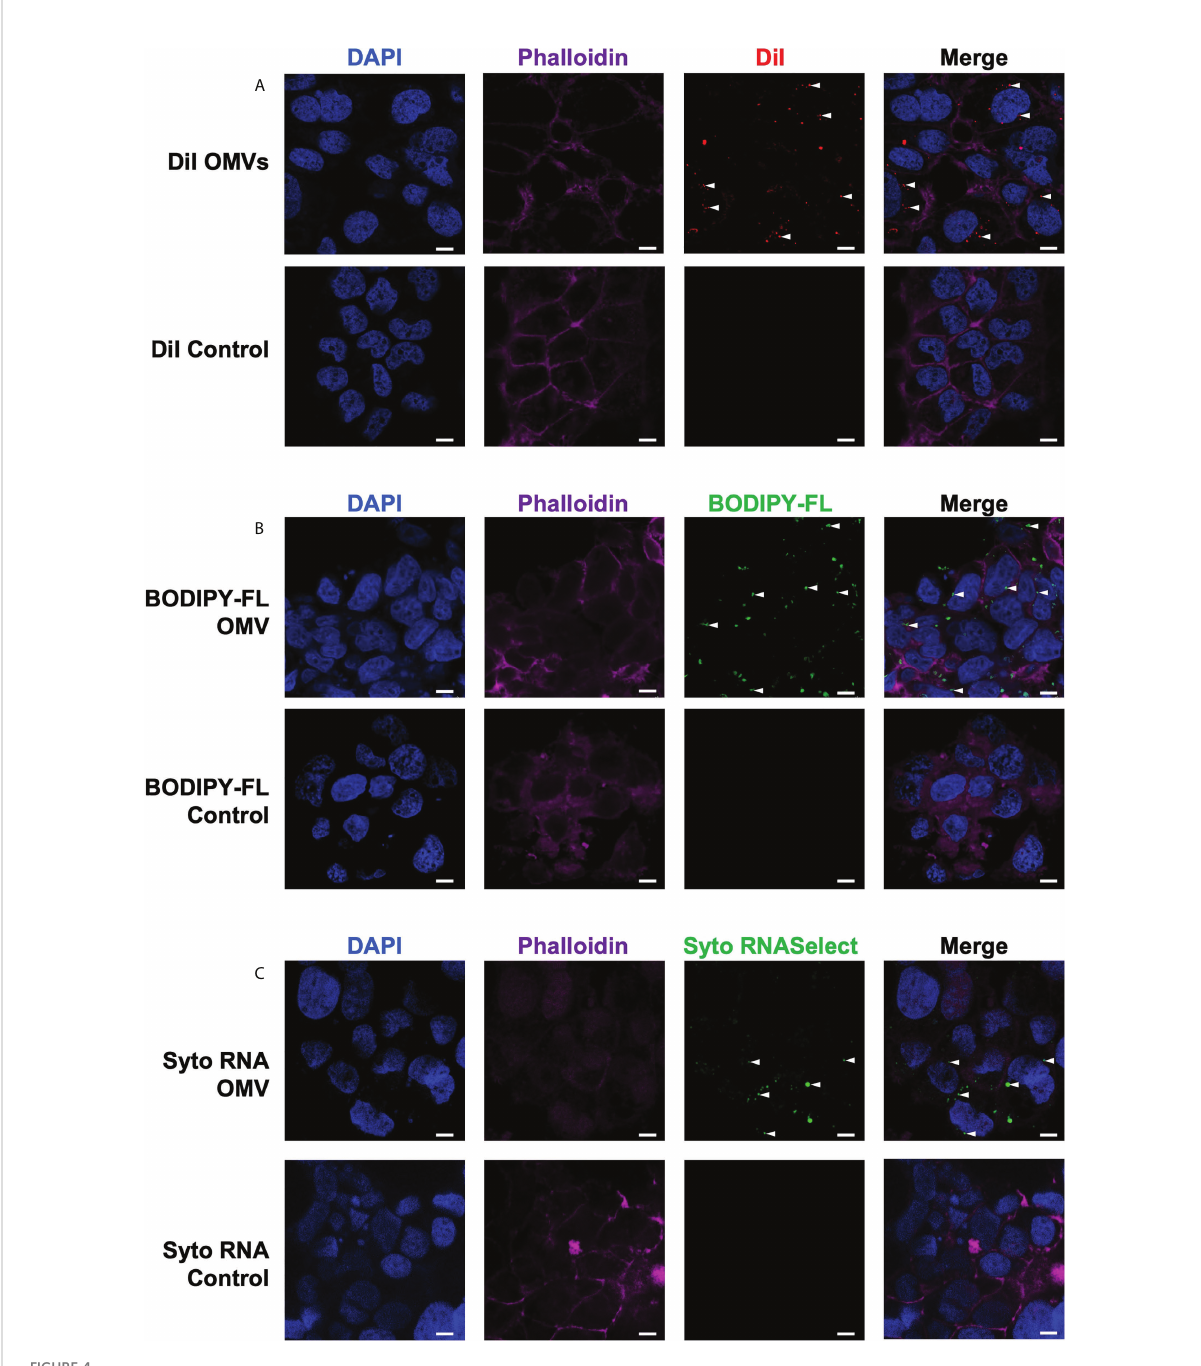
FIGURE 4 B fragilis OMVs enter host intestinal epithelial cells and transport their peptidoglycan and RNA cargo intracellularly. The (A) lipid (DiI; red), (B) peptidoglycan (BODIPY-FL vancomycin; green) and (C) RNA (Syto RNASelect; green) cargo associated with B. fragilis OMVs was fl uorescently labelled. Fluorescently labelled B. fragilis OMVs were then incubated with Caco-2 cells for 4 hours, and OMV entry was visualized by confocal microscopy. Cell nuclei and cellular actin were visualized by staining with DAPI (blue) or Phalloidin (magenta). Intracellular B. fragilis OMVs are indicated by white arrows. DPBS containing each respective stain (Control) were incubated with Caco-2 cells to control for the non-speci fi c uptake of each fl uorescent stain by host cells. Images are representative of three biological replicates of Caco-2 cells stimulated with each type of fl uorescently-labelled B. fragilis OMVs. Scale bar = 10 m